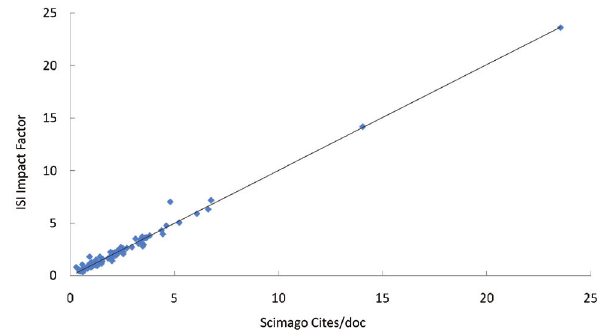
Figure 1 - Impact Factors vs Cites/Document for 99 randomly selected ISI journals (r=0.981; slope = 1.004; p <0.001). Figure 2 correlates IF vs. SJR, for the journals shown in Figure 1: a highly significant correlation (r = 0.884; p <0.01)